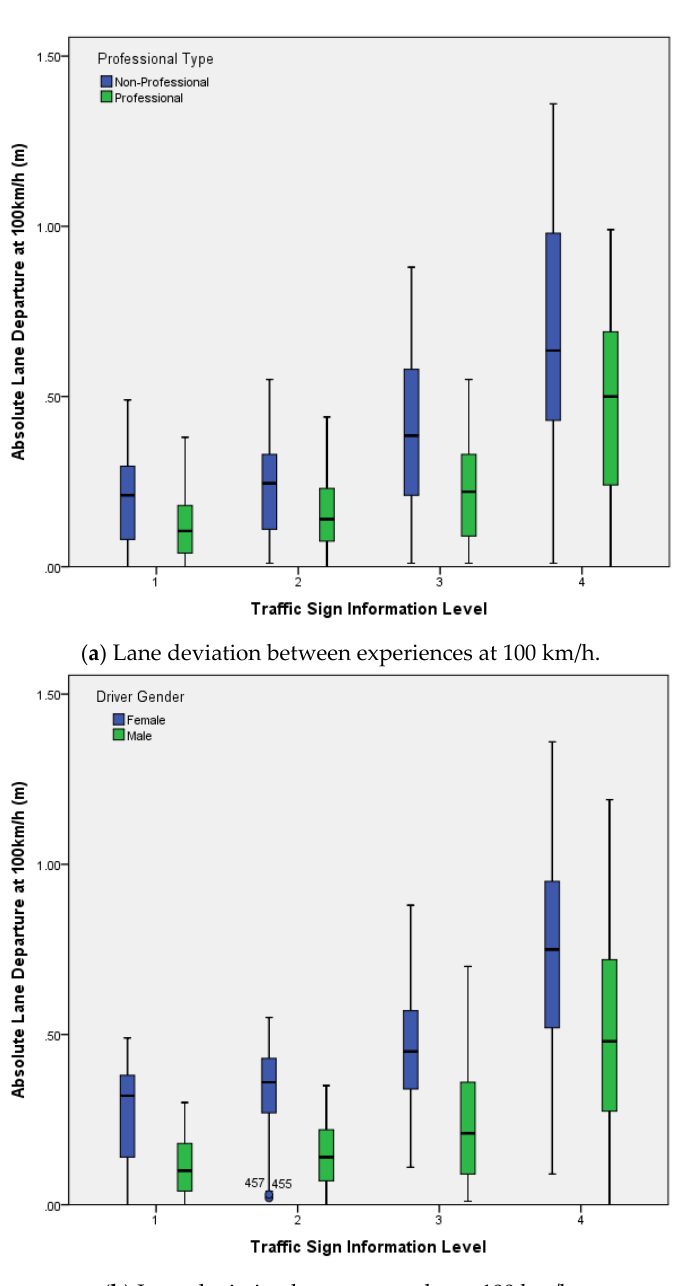
Figure 9. Lane deviations in different sign information levels.